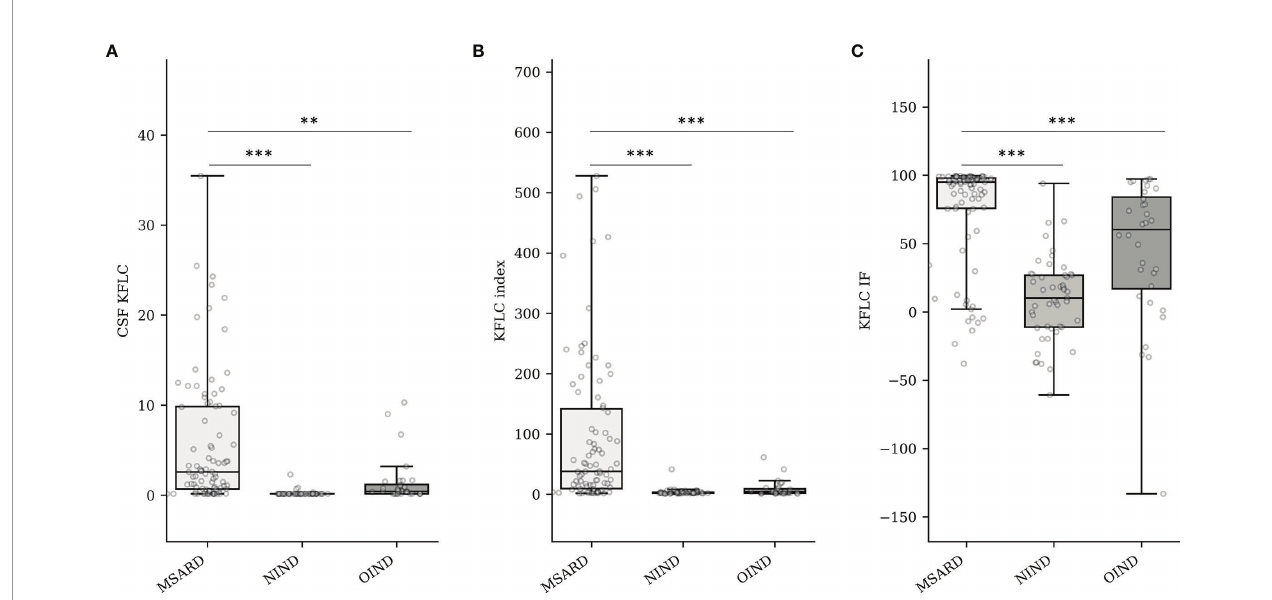
FIGURE 1 | Quanti fi cation of CSF KFLC (mg/L) (A) , KFLC index (B) , and KFLC IF (%) into groups (C) . MSARD, multiple sclerosis and related disorder ( n = 88); NIND, non in fl ammatory neurological disorder ( n = 53); OIND, other in fl ammatory neurological disorder ( n = 35). ** determined a p -value < 0.01. *** determined a p - value < 0.001. CSF, cerebrospinal fl uid; KFLC, kappa free light chains; IF, intrathecal